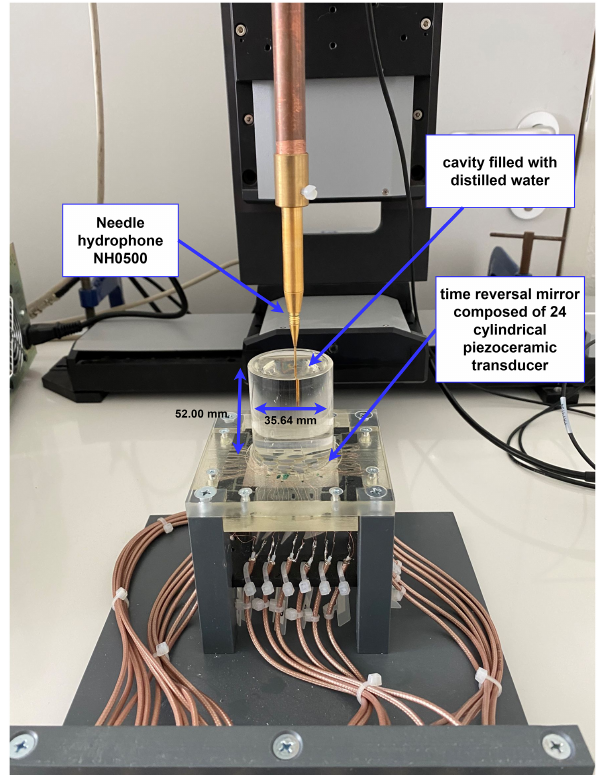
Figure 9. Demonstrator realized on the basis of the simulation re- sults, composed of the water-filled cavity and the time reversal mir- ror. The cavity contains a needle hydrophone for the time reversal